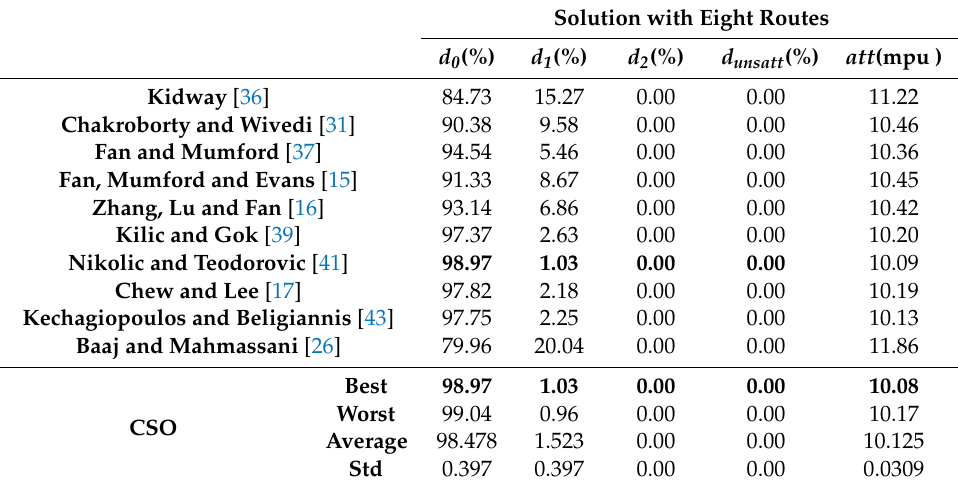
Table 8. Comparative results for the best eight-route solutions for Mandl’s network. Solution with Eight Routes